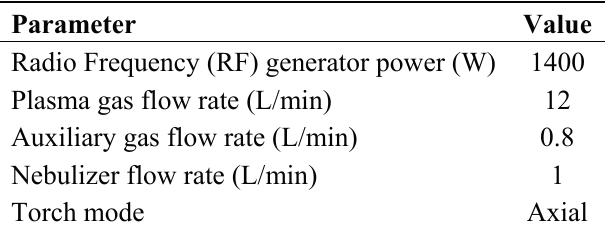
Table 3. Instrumental parameters of the